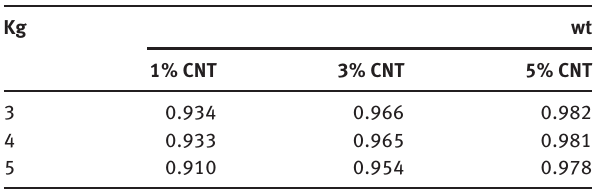
Table 2: Weight loss ratio with respect to load for various wt% of CNTs.